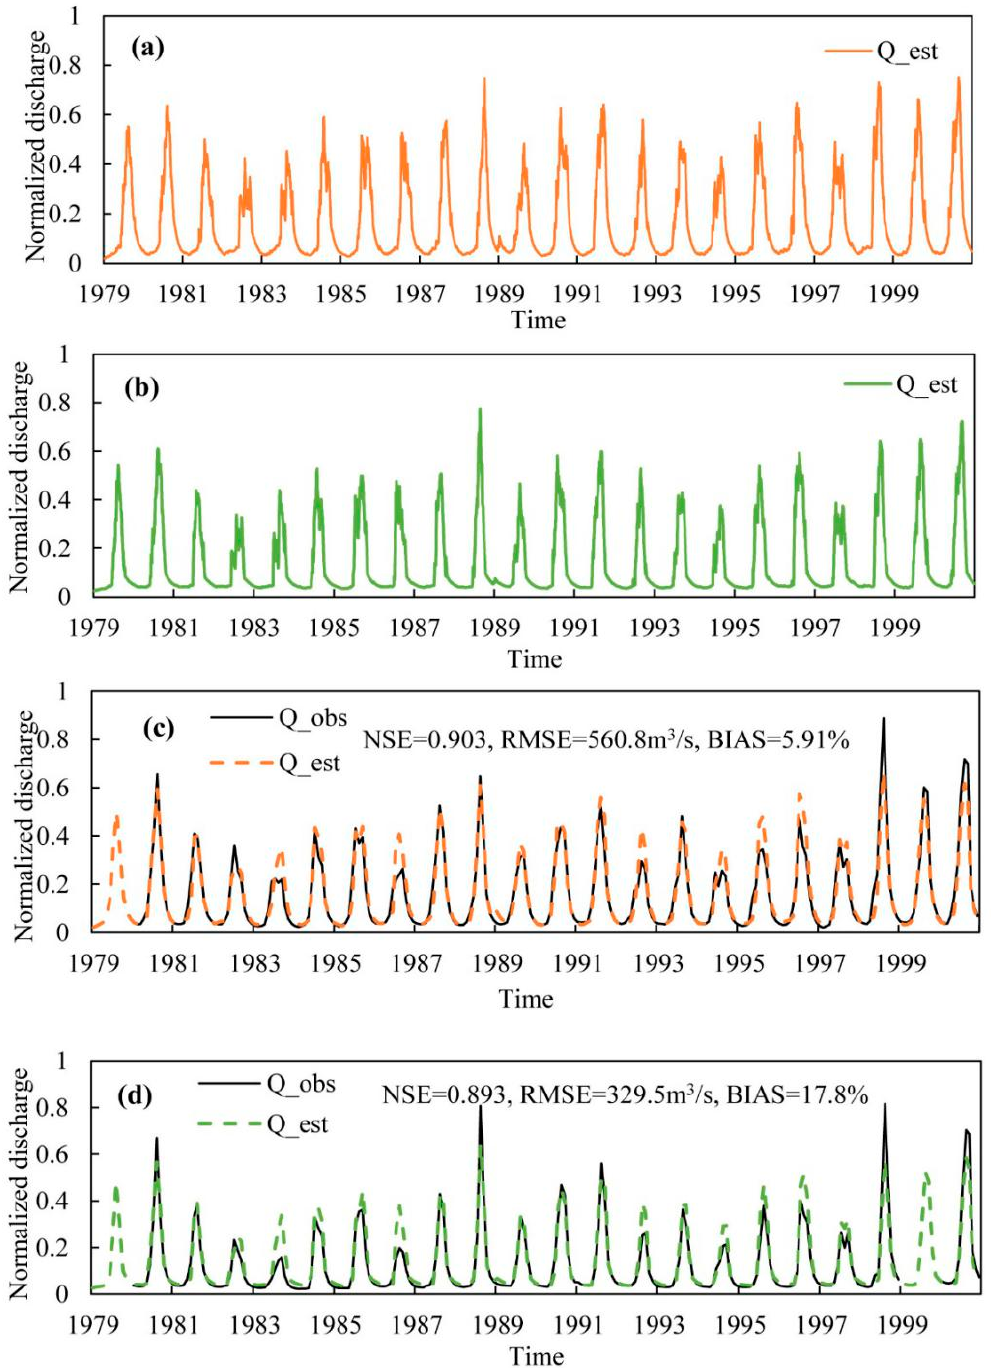
Figure 10. The normalized daily discharge estimates from the segmented CMFD precipitation upstream of Nuxia ( a ) and Yangcun ( b ). Additionally included is a comparison between observations and estimates of normalized monthly streamflow (based on the segmented CMFD precipitation) upstream of Nuxia ( c ) and Yangcun ( d ).